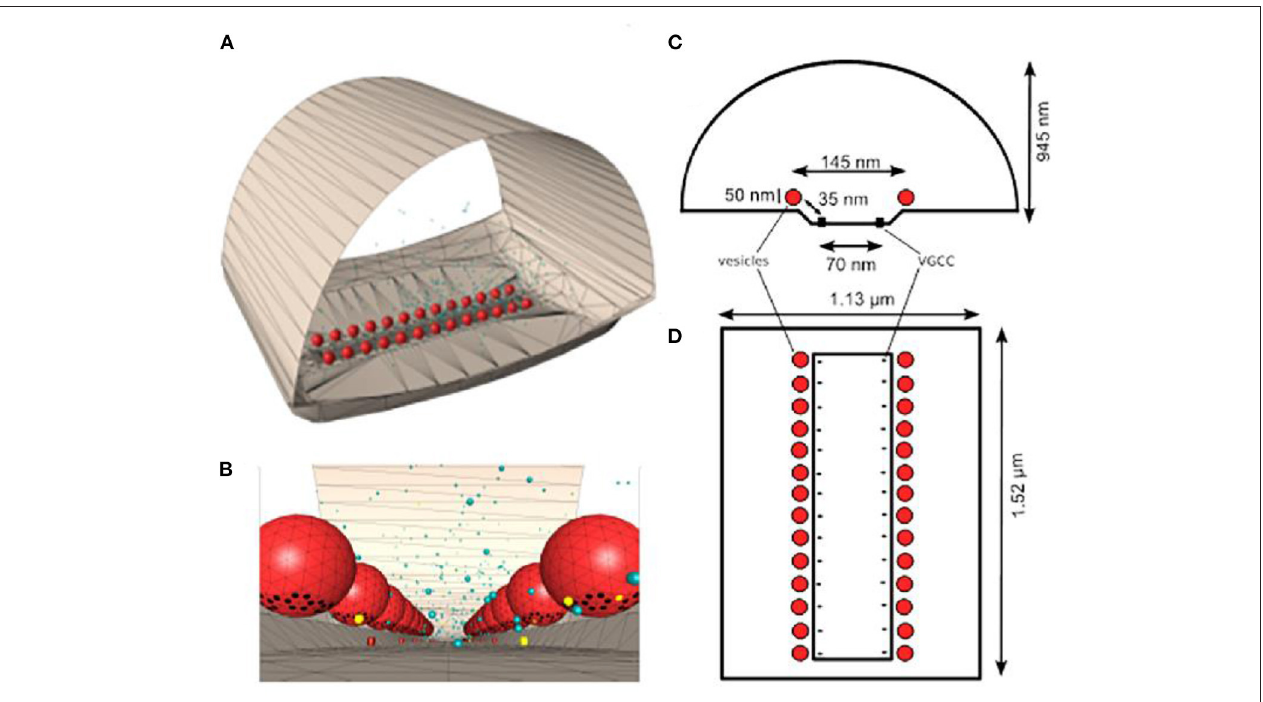
FIGURE 2 | Frog MCell model. (A) MCell model of one AZ from the frog NMJ (equivalent to one linear red stained AZ in Figure 1B . (B) Enlarged view from within the frog MCell AZ model near the base of docked synaptic vesicles (red spheres) that includes synaptotagmin-1 binding sites (black dots). Calcium ions are shown as free (yellow dots) or bound to calcium buffer (blue dots). The 3-D models in (A,B) were created via CellBlender based on ultrastructural data from the adult frog NMJ. (C) Cross-section diagram of the distribution of VGCCs (black dots) and docked synaptic vesicles (red circles). (D) top view diagram of 26 N-type VGCCs; black dots) positioned in a 1:1 stoichiometric relationship with docked synaptic vesicles (red circles). Adapted from Dittrich et al.